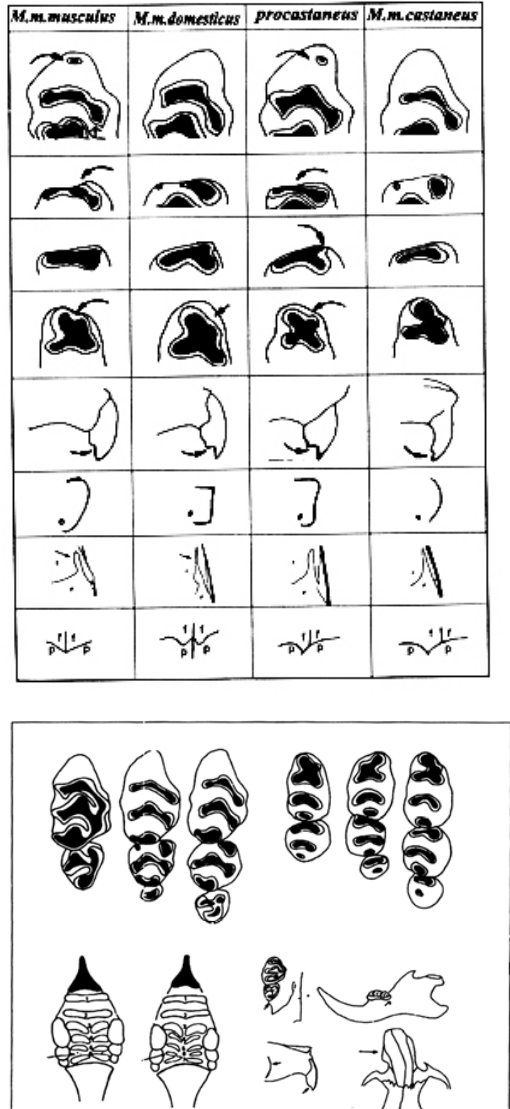
F IG . 9- Polymorphism of molars and skull characters in Indonisian house mouse. Reduction of intermolars palatine folds (IMPF) to 4 and absence of third molars and distortion of roster (Darvish